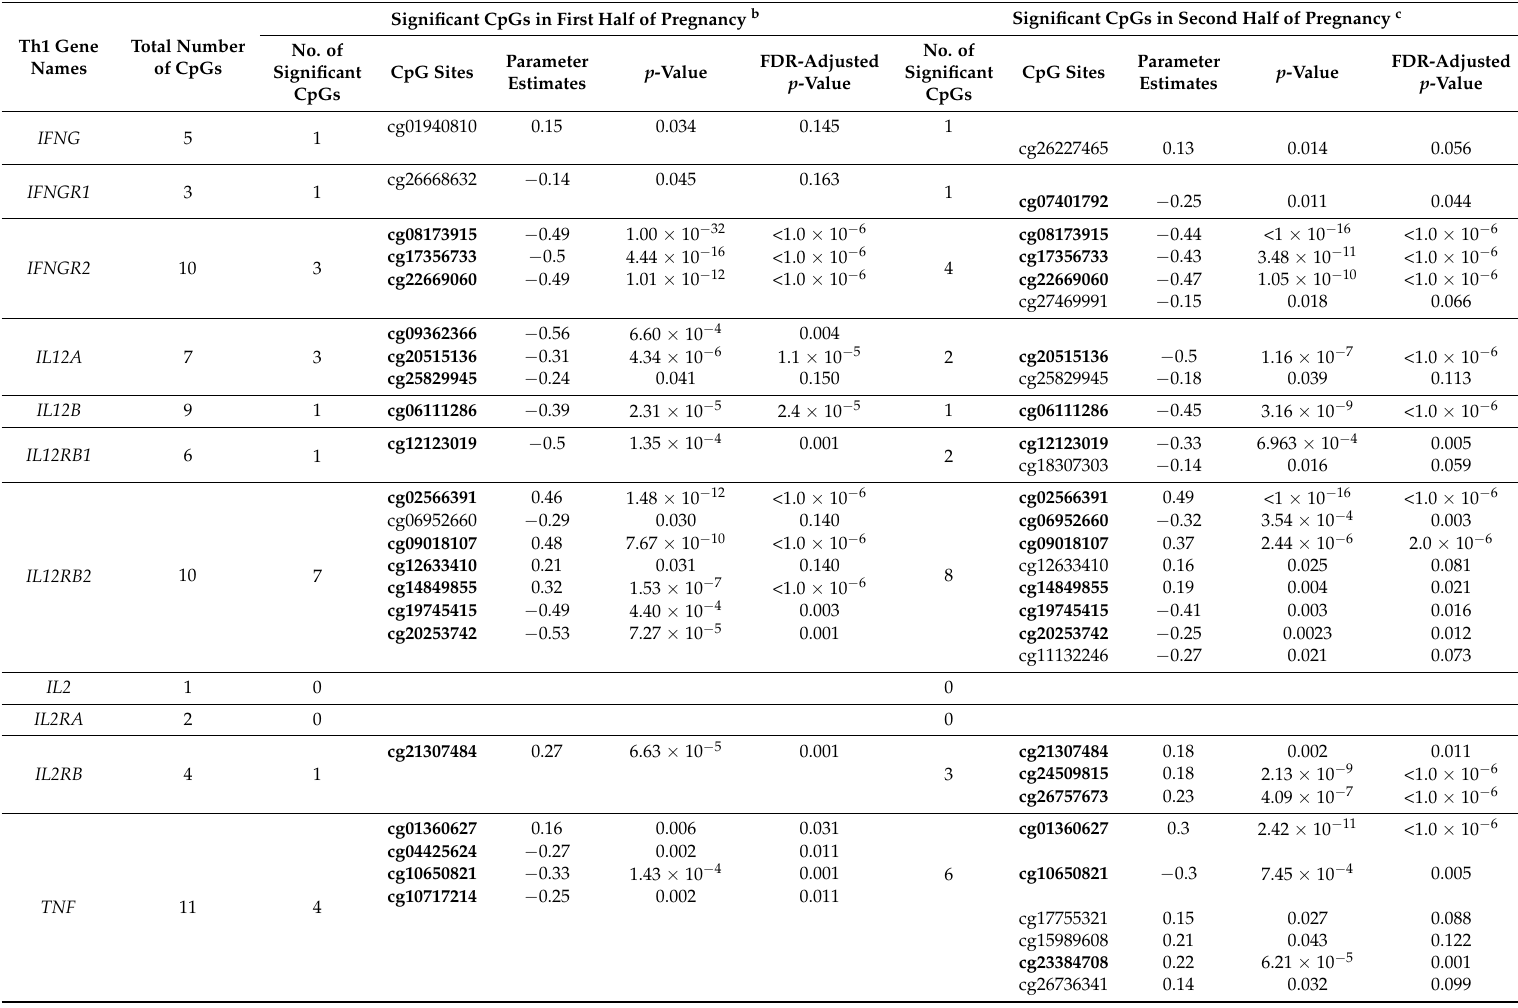
Table 2. Th1 CpGs showing statistically significant changes ( p ≤ 0.05) during first and second halves of pregnancy a